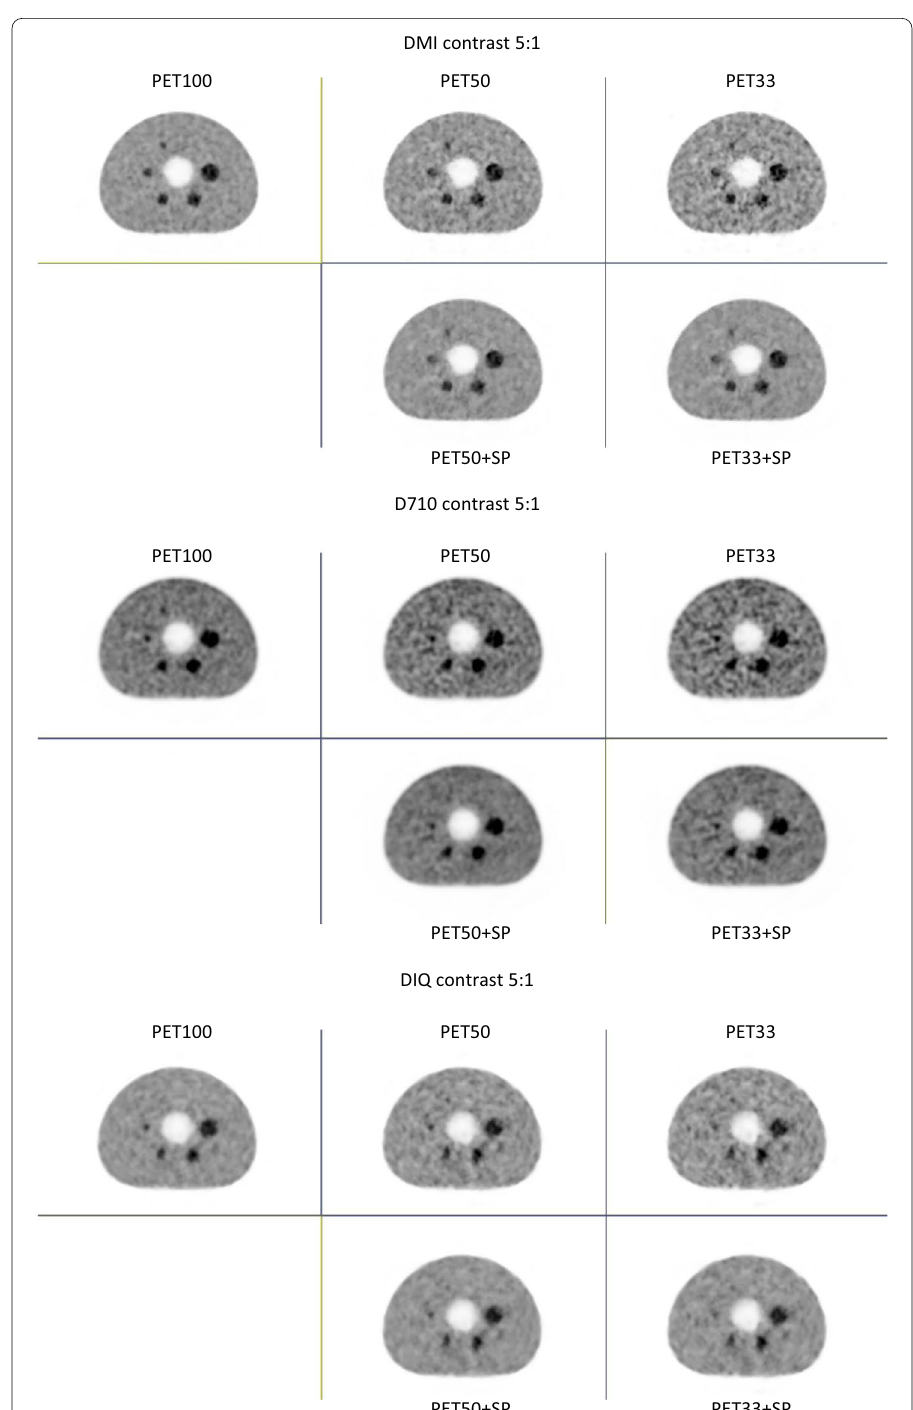
Fig. 2 Images from the IEC phantom acquisition for a contrast of 2:1, for each PET system (Top image: DMI; Middle image: D710 and bottom image: IQ4), acquisition time (1st column: PET100, 2nd colomn: PET50 and 3rd column: PET33) and the application of SubtlePET (2nd row of each